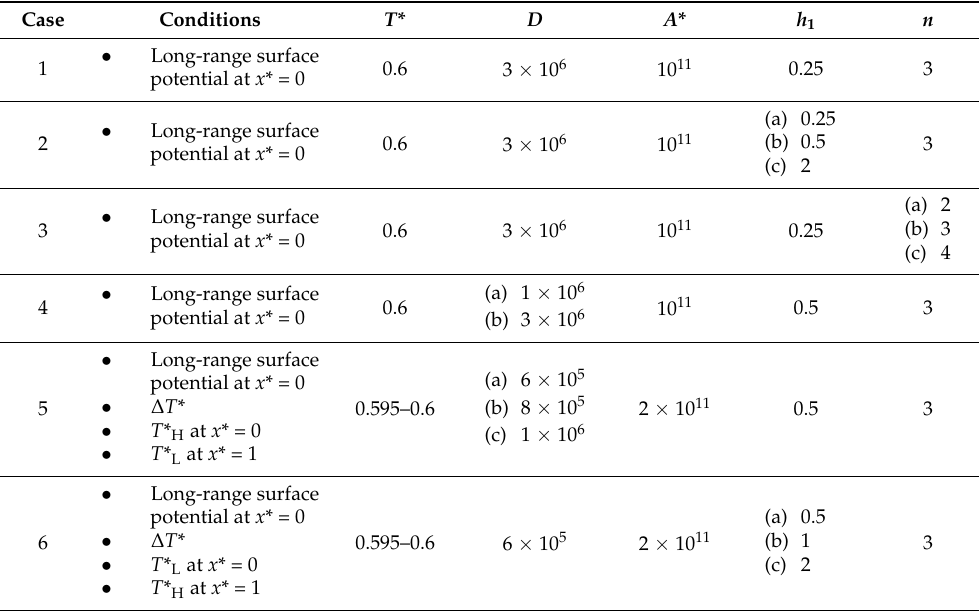
Table 1. The parameters and conditions considered for each case. For all cases, c 0 * = 0.6, σ = 99, γ = 1, g = − 0.5, E a * = 10, and ψ =